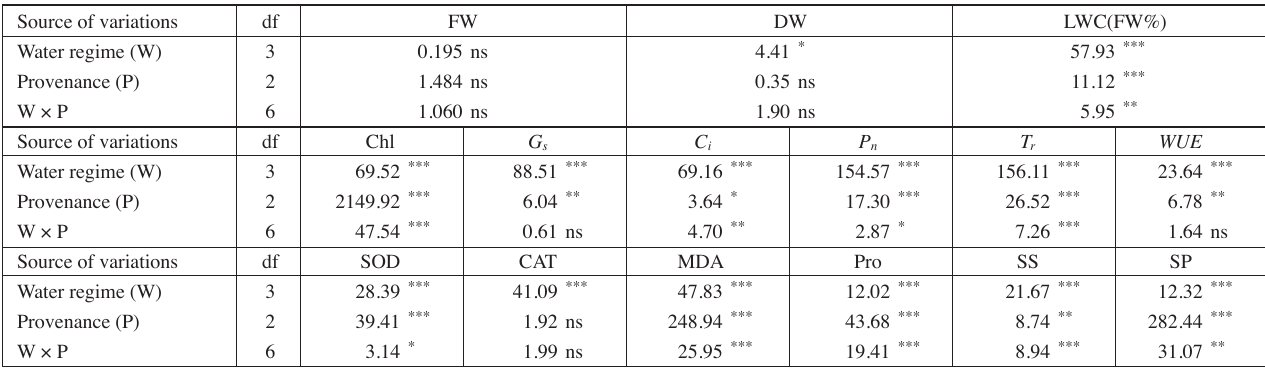
Tab. 2: F values derived from analysis of variance (ANOVA) of data for physiological attributes on three provenances of Dioscorea nipponica Makino exposed to varying water